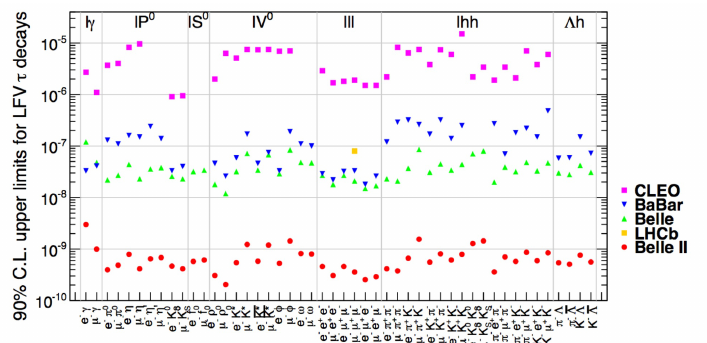
Figure 8. Expected upper limits on LFV τ decays 90% CL for 50 ab − 1 .